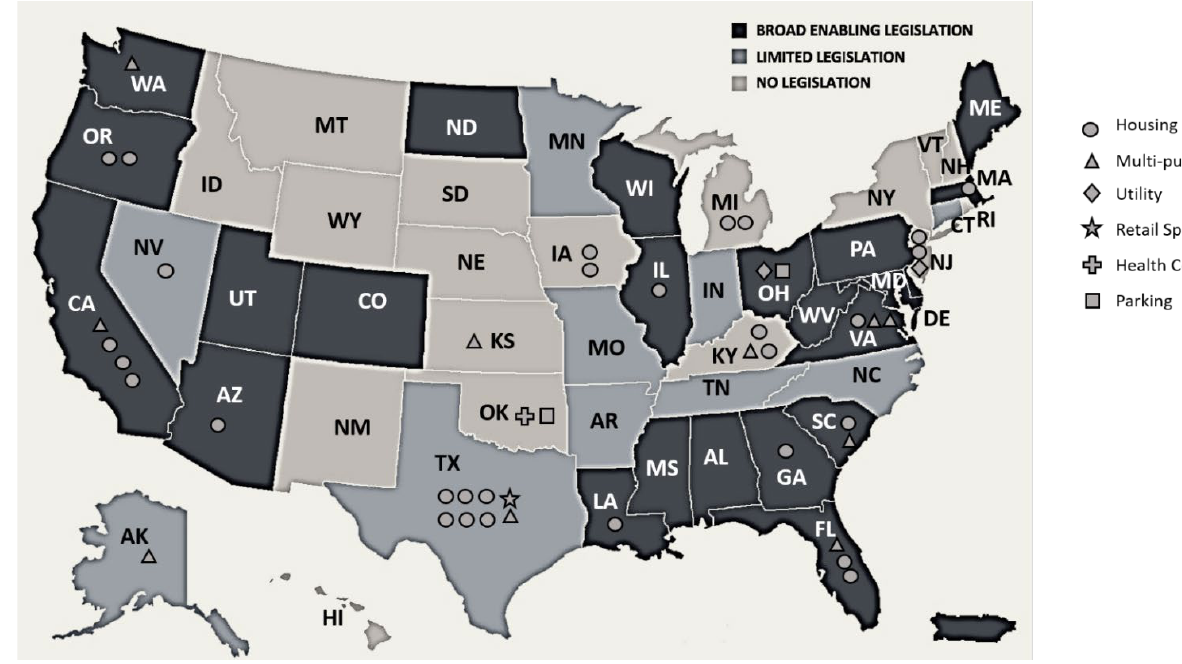
Figure 1. Map of the types of PPP Projects.